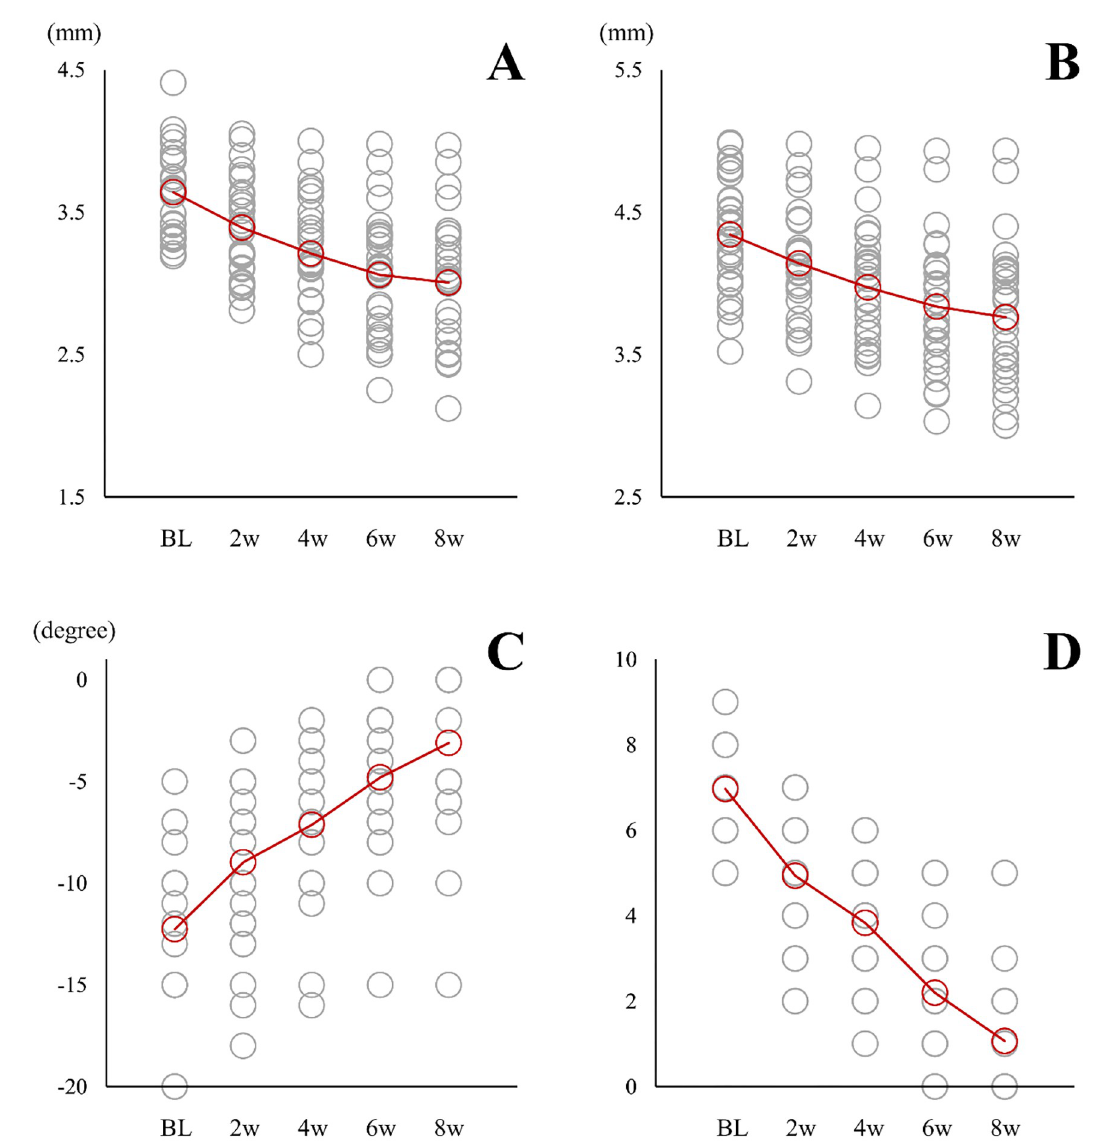
Fig 3. Temporal changes in the parameters. Each scatterplot indicates non-weight-bearing medial meniscal extrusion ( A ), weight- bearing medial meniscal extrusion ( B ), range of motion ( C ), and knee pain according to the numerical rating scale ( D ). Red and gray circles show mean values and values in each patient, respectively. Abbreviations: BL,